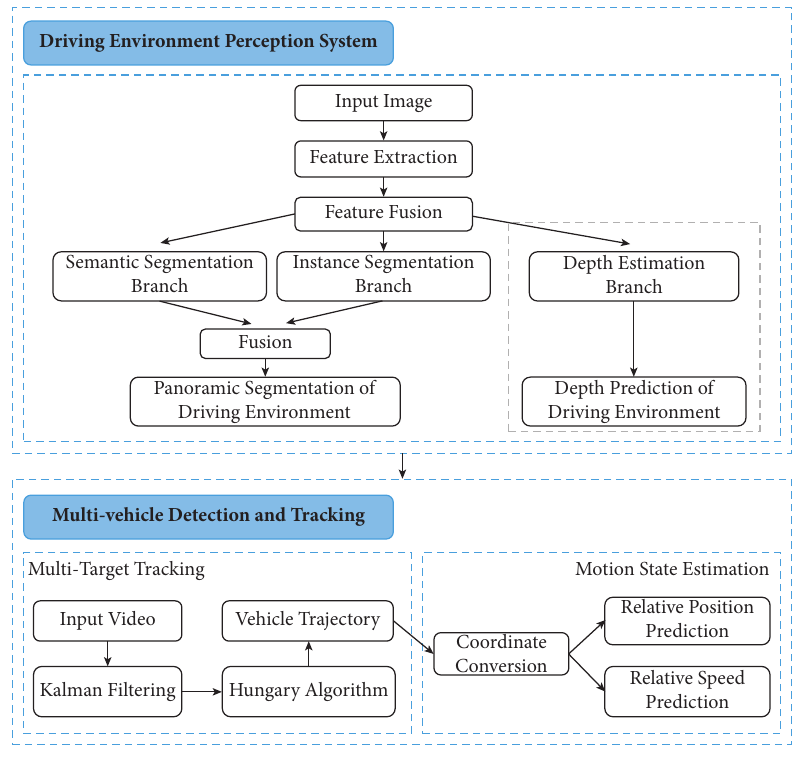
Figure 1: Methodology